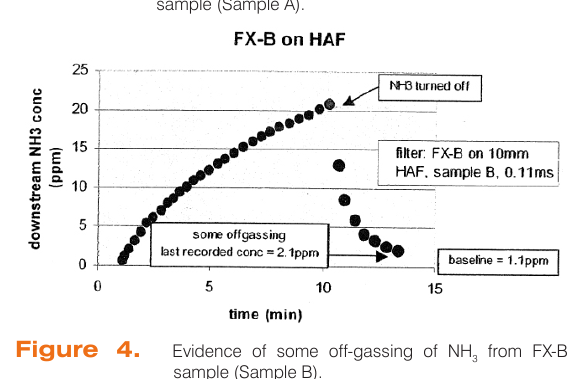
Figure 6. “Recharging” of FX-A sample (Sample A). from FX-A 2